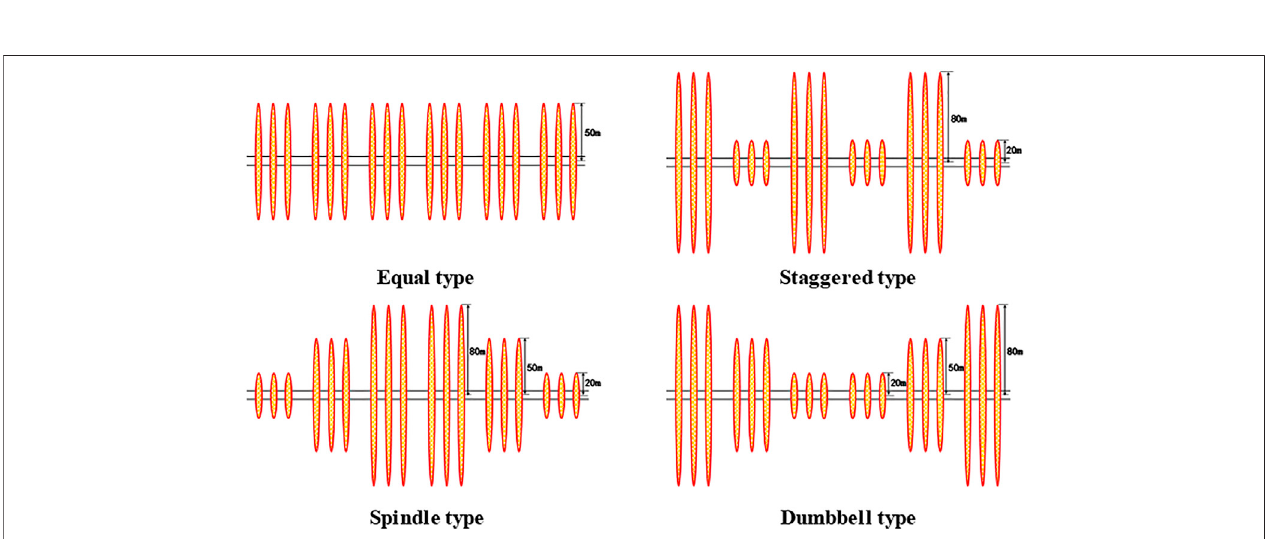
FIGURE10| Cumulativecondensateandgasproductioncurves (A) andlocalpressuredistributionmapofhorizontalwells (B) underdifferentnumberofsecondary fractures.